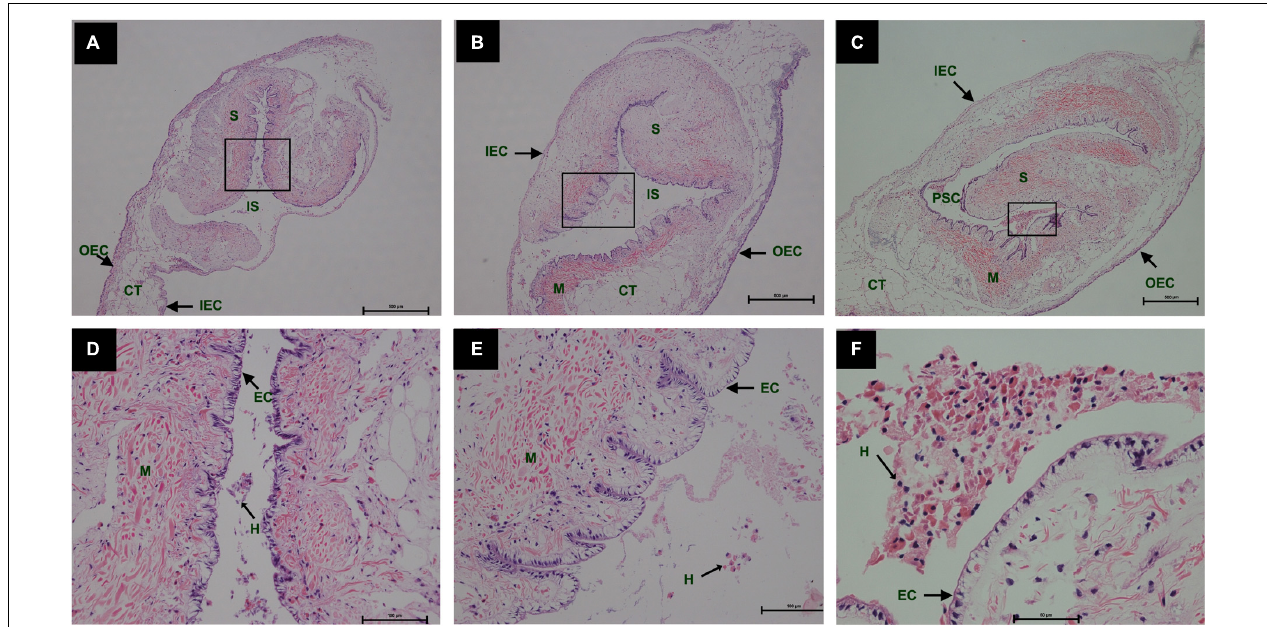
FIGURE 1 | Histology of pearl sac development in Hyriopsis cumingii on days 2, 4 and 6 after grafting by Haematoxylin-Eosin staining. (A–C) are overview of free saibo implanted in the connective tissue of pallial mantle of host mussel on days 2, 4, and 6, respectively. The black boxes indicate the areas shown at higher magnification. (D–F) are the high magnification views of partial area of saibo in panels (A–C) , respectively. The abbreviations indicate S, saibo, H, hemocyte, CT, connective tissue, EC, epithelial cell of saibo, IS, interspace in saibo, OEC, outer epithelial cell of pallial mantle, IEC, inner epithelial cell of pallial mantle, M, muscle.